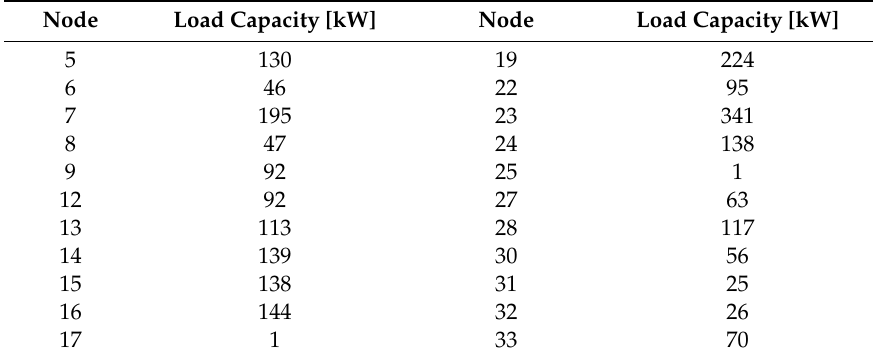
Table 1. Load capacity in low-voltage distribution system.